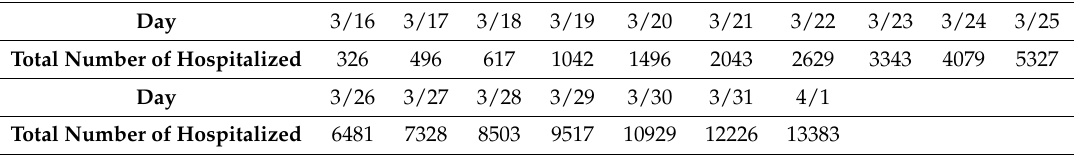
Table 4. Total number of daily current hospitalizations reported in NY state from 16 March to 1 April. See